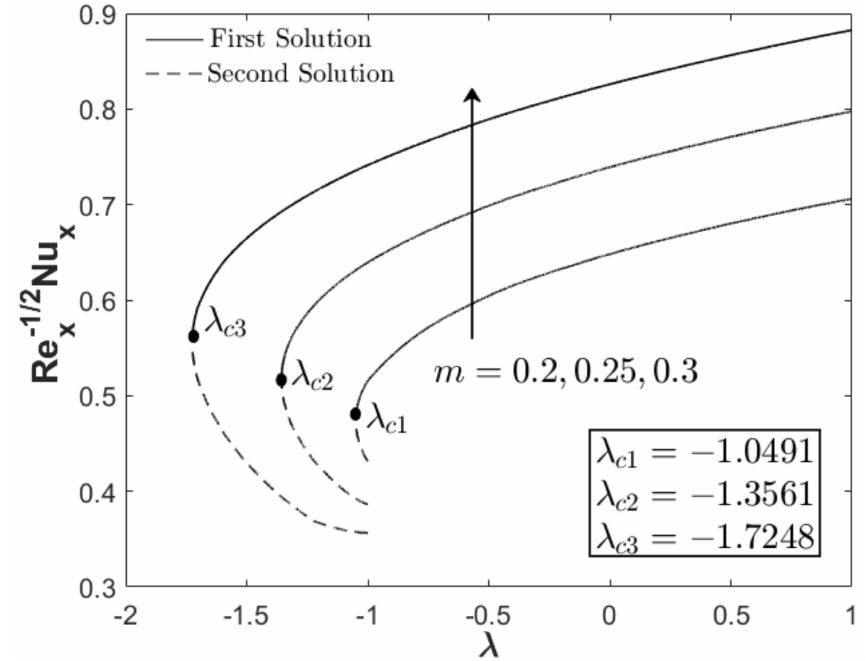
Figure 3. Re − 1/2 x Nu x towards λ when S = 0.05, φ hnf = 0.02, and different m